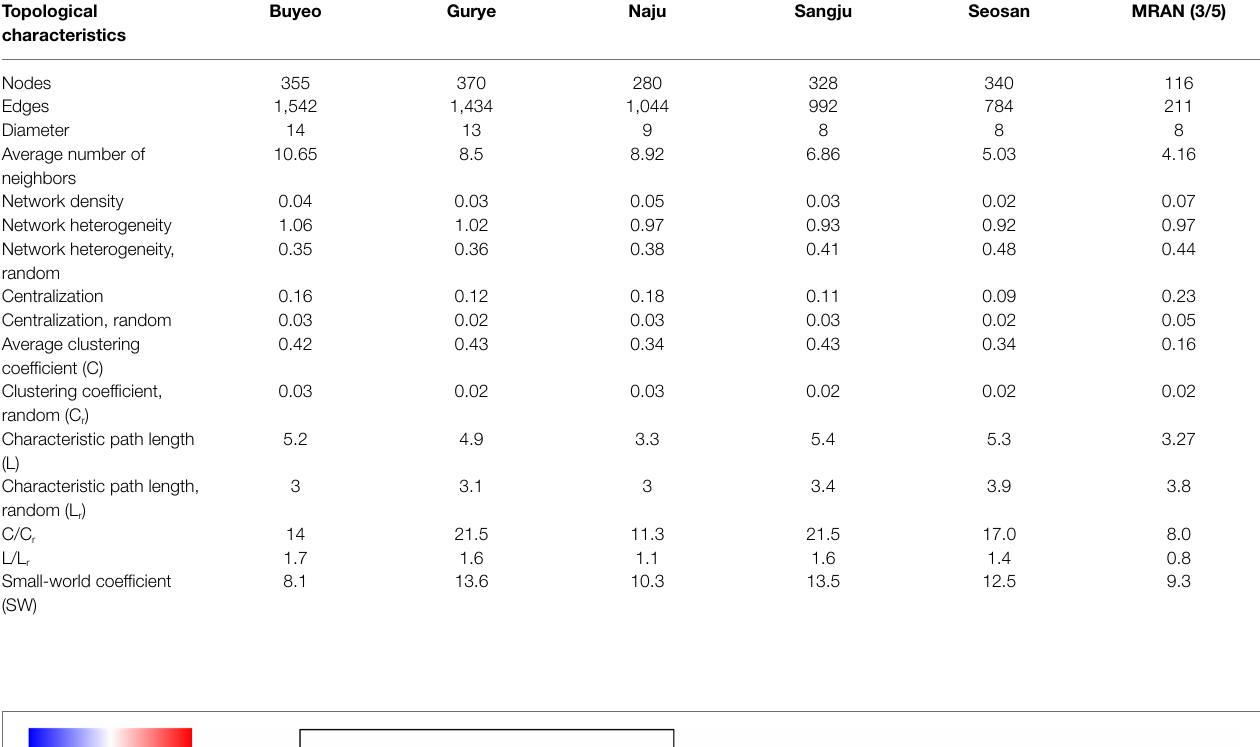
TABLE 3 | Topological characteristics of microbial networks.